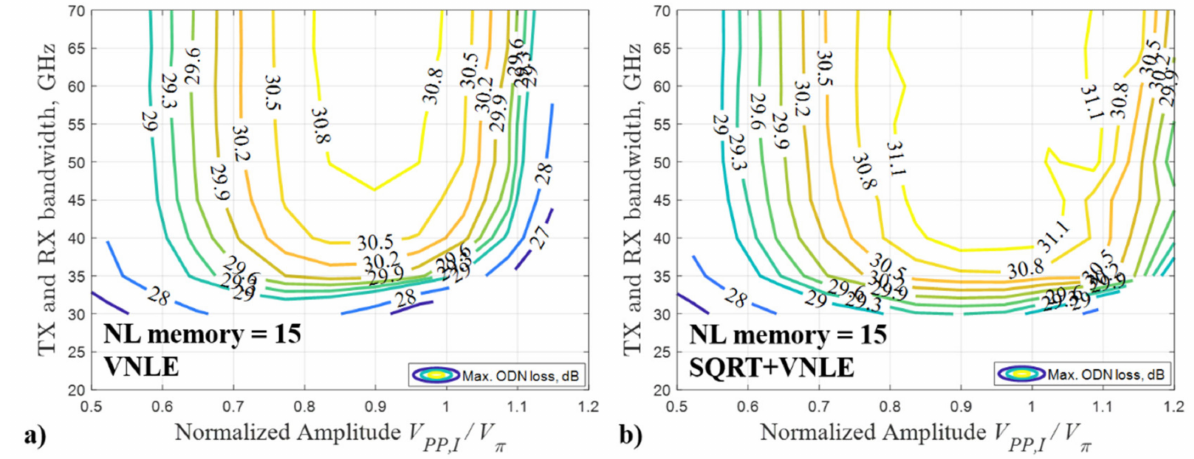
Figure 4. Maximum ODN loss at BER T = 10 − 2 as a function of TX and RX bandwidth and of the normalized peak-to-peak amplitude of the in-phase signal V PP , I / V π with NL memory = 15 samples. The fiber length is L = 20 km. The transmitted optical power is TOP = 15 dBm: ( a ) VNLE; and ( b ) SQRT + VNLE.